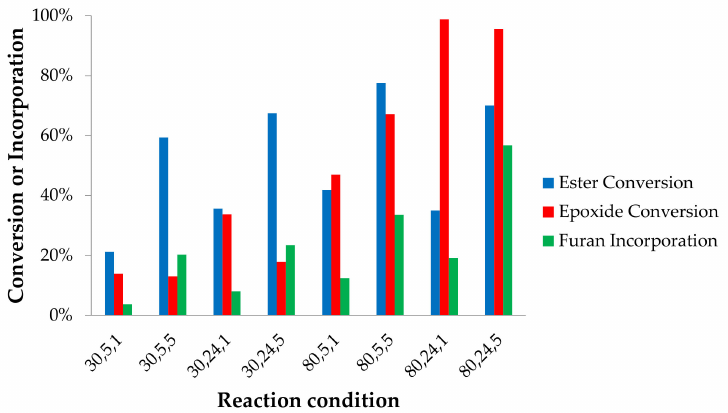
Figure 5. Ester and epoxide conversions, and furans attachment of the reactions with 50% of LiBr loading. The x-axis indicates reaction conditions: temperature ( ◦ C), time (h), molar ratio of furfurylamine to